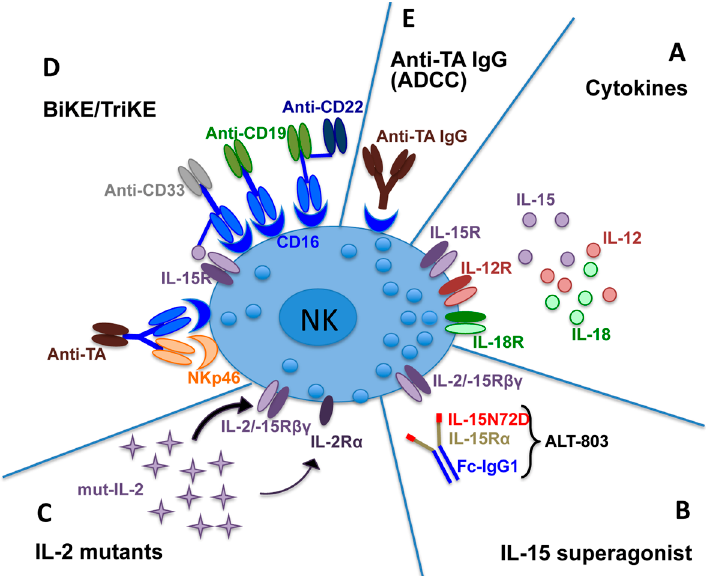
Figure 2. Different strategies can be used to induce activation and expansion of natural killer (NK) cells to improve tumor killing. (A) Cytokines, such as interleukin (IL)-15, IL-12, and IL-18 to generate cytokine induced memory-like NK cells (CIML-NK); (B) IL-15 superagonist ALT-803, an IL-15 mutant (IL-15N72D) bound to a soluble, dimeric IL-15R α Fc fusion protein (IL-15R α -Fc); (C) IL-2 mutants with high affinity for IL-2R βγ present on NK cells, but reduced affinity for IL-2R α expressed on Treg cells; (D) activating NK cell receptor engagement by the use of bispecific or trispecific killer engagers (BiKE or TriKE), capable of binding CD16 on NK cells and one/two tumor antigen(s) (e.g., CD19, CD22, CD33) or CD16 and NKp46 on NK cells and one tumor antigen; (E) tumor-specific antibodies (IgG), capable of inducing the NK-antibody dependent cell-mediated cytotoxicity(ADCC). TA, tumor antigen.